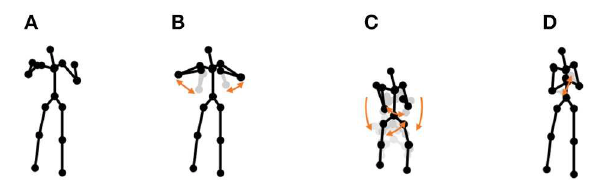
FIGURE 10 | Four unit motions included in the chicken dance: (A) beaks, (B) wings, (C) tail feathers, and (D) claps.